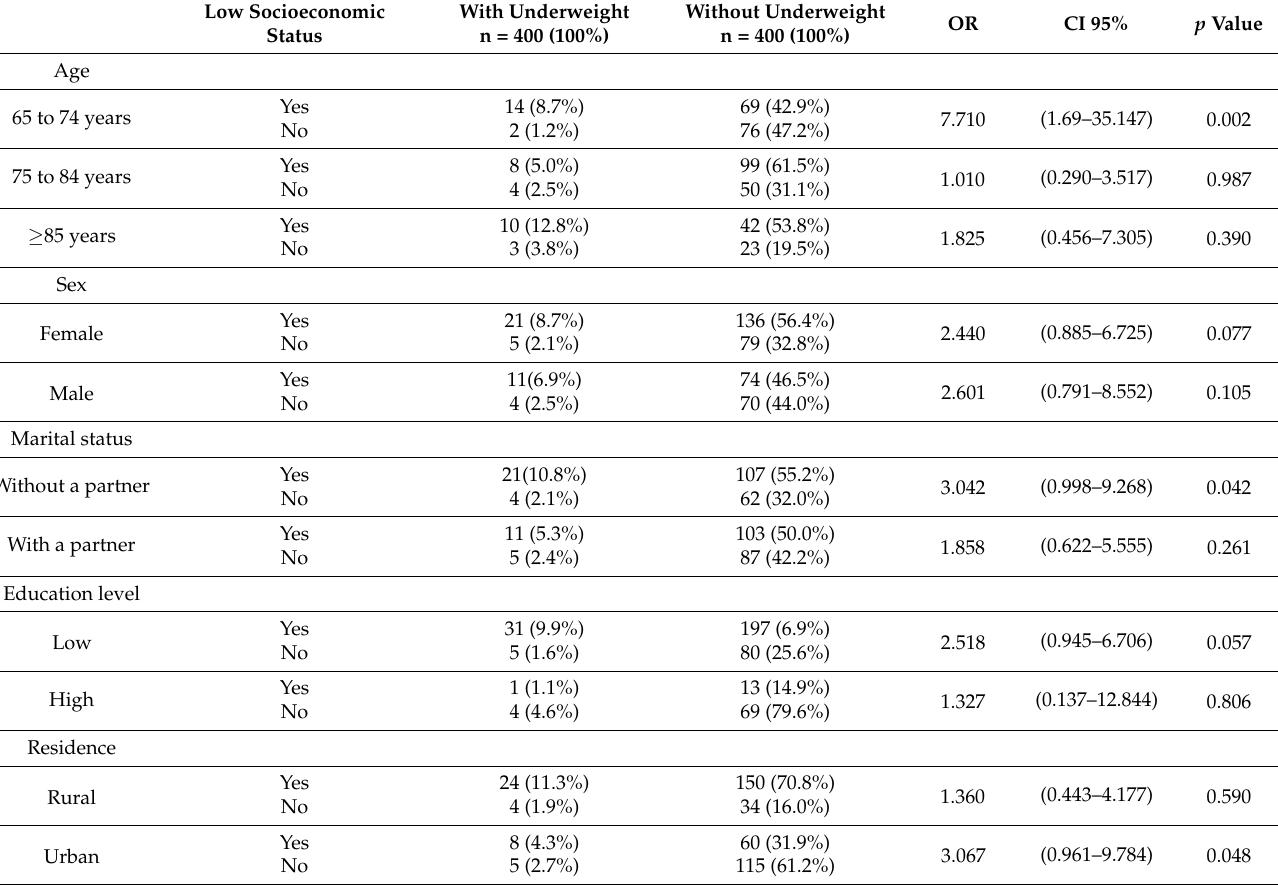
Table 3. Relationship between underweight and low socioeconomic status in older adults according to sociodemographic